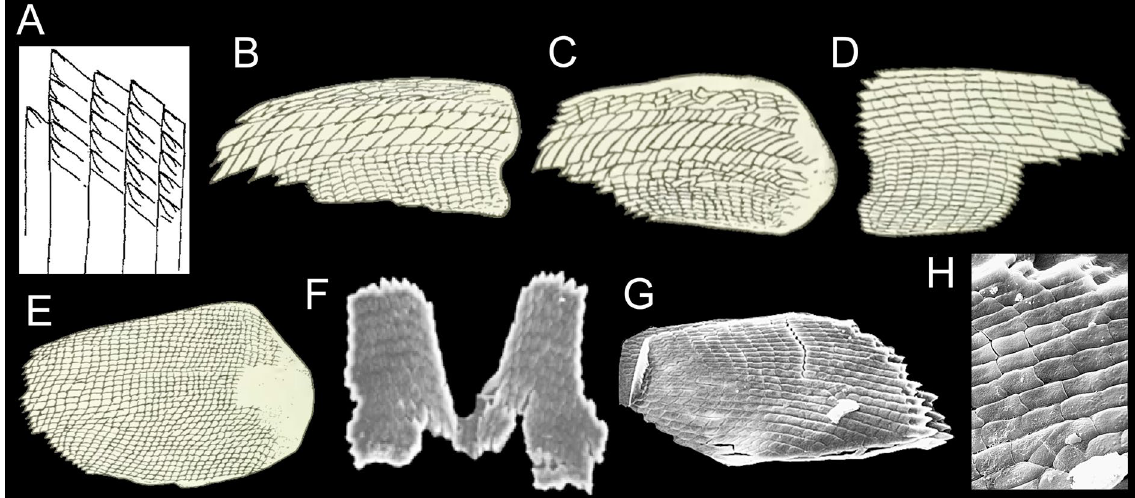
Fig. 33. Drawings and SEM micrographs of the jaw of triphorids in previous works. All permissions were obtained from authors and journals (see ‘Acknowledgments’). A . Differoforis